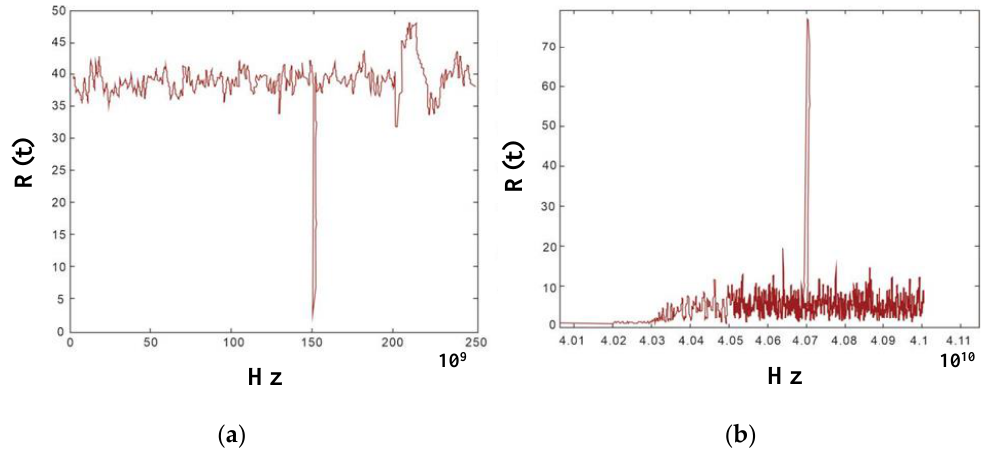
Figure 6. ( a ) Coarse synchronization. ( b ) Fine synchronization.